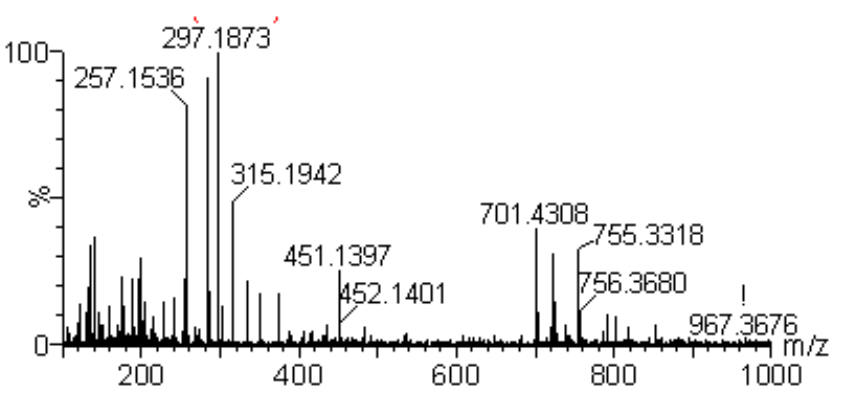
Figure 4. ESI (+) MS spectrum of compound 6